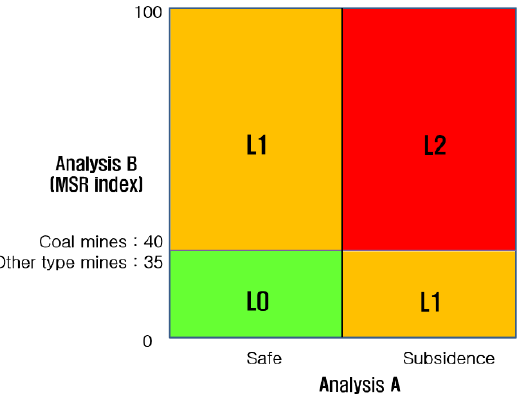
Figure 16. Subsidence risk grade diagram.